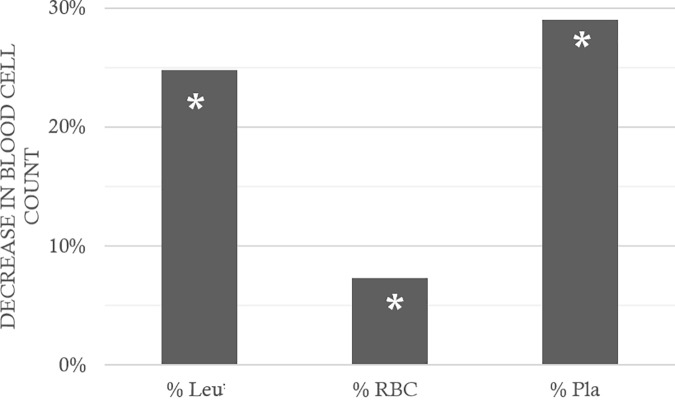
Fall in blood cells count, between before and after the hyperbaric exposure. Leu: leukocytes; RBC: Red Blood Cells; Pla: Platelets. As a result showed hemoconcentration linked to the hyperbaric exposure, the blood parameters registered after the dive was corrected individually depending on the variation in the hematocrit, and then compared to the first blood punctures to present their changes (%) on the histogram. ∗ notes significant difference (p < 0.05) between before and after the dive for the same parameter.